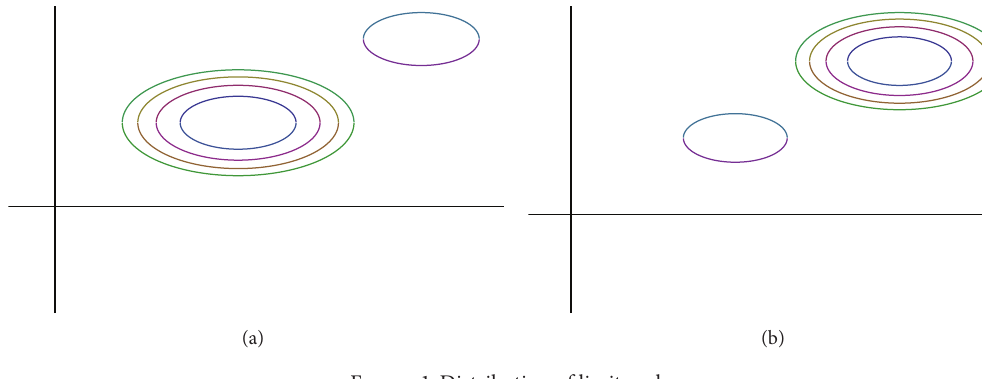
Figure 1: Distribution of limit